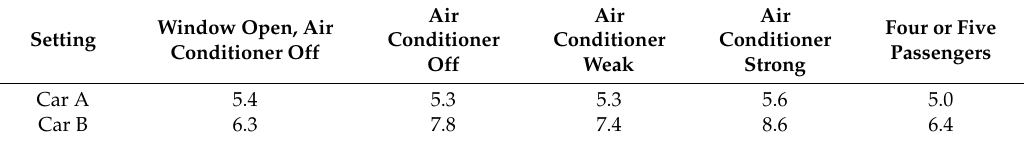
Table 3. Measured initial time delay gap ( ITDG ) [ms] for Experiment